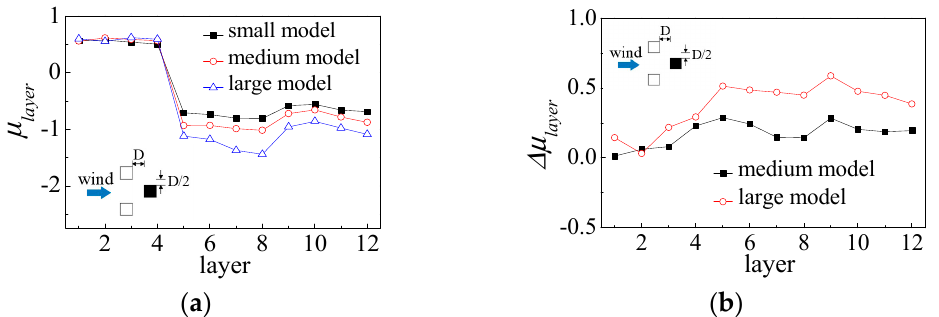
Figure 12. Wind tunnel test results of test condition 3. ( a ) Layer pressure coefficient; ( b ) relative error of layer pressure coefficient.